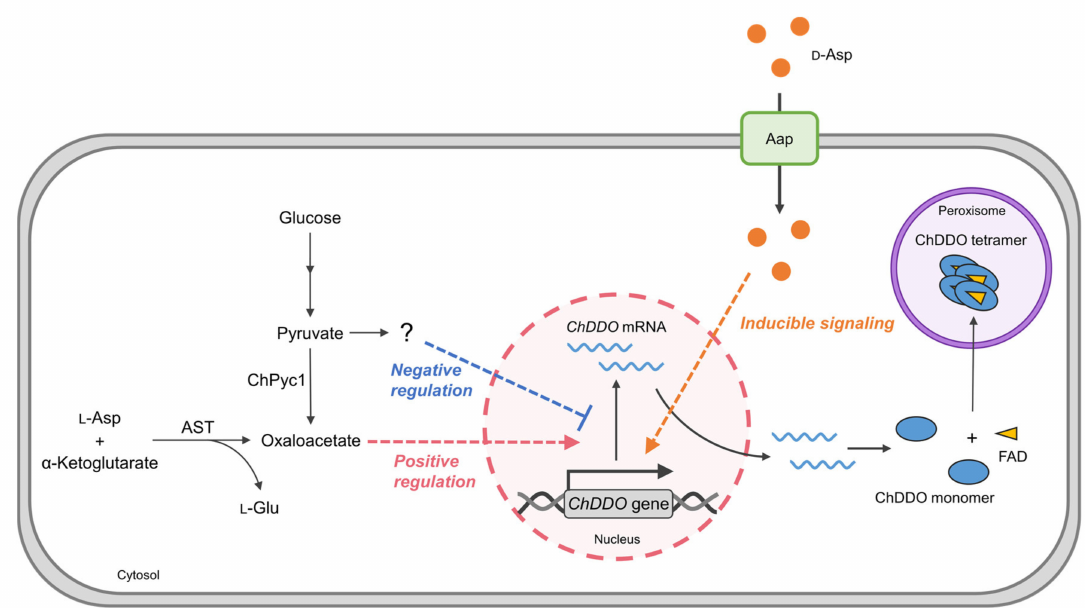
Figure 7. Relationship between ChPyc1 activity and ChDDO gene expression in the yeast C. humicola strain UJ1. D -Asp taken up into the cytosol by Aap induces ChDDO gene transcription via an unknown signaling pathway. Chpyc1 is indirectly involved in the regulation of ChDDO transcription via pyruvate metabolism. Pyruvate metabolisms by ChPyc1 and other enzyme(s) might regulate ChDDO gene inducible transcription by D -Asp positively and negatively,